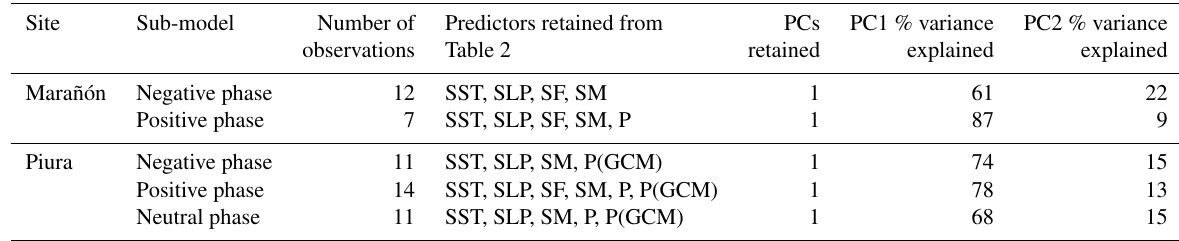
Table 3. Final predictors included in each sub-model.